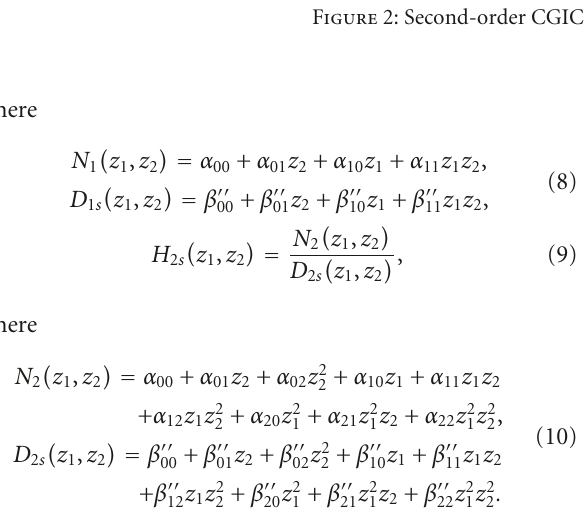
Figure 2: Second-order CGIC-PA rotated digital filter